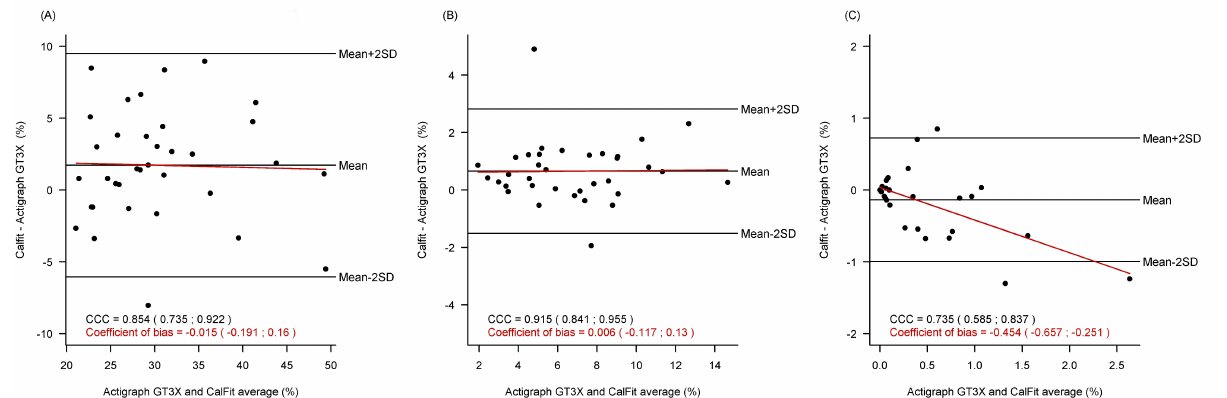
Figure 3. Agreement between CalFit and Actigraph GT3X for duration of light, moderate, and vigorous physical activity within the coinciding measurement time periods. (A) duration of light physical activity, (B) duration of moderate physical activity, and (C) duration of vigorous physical